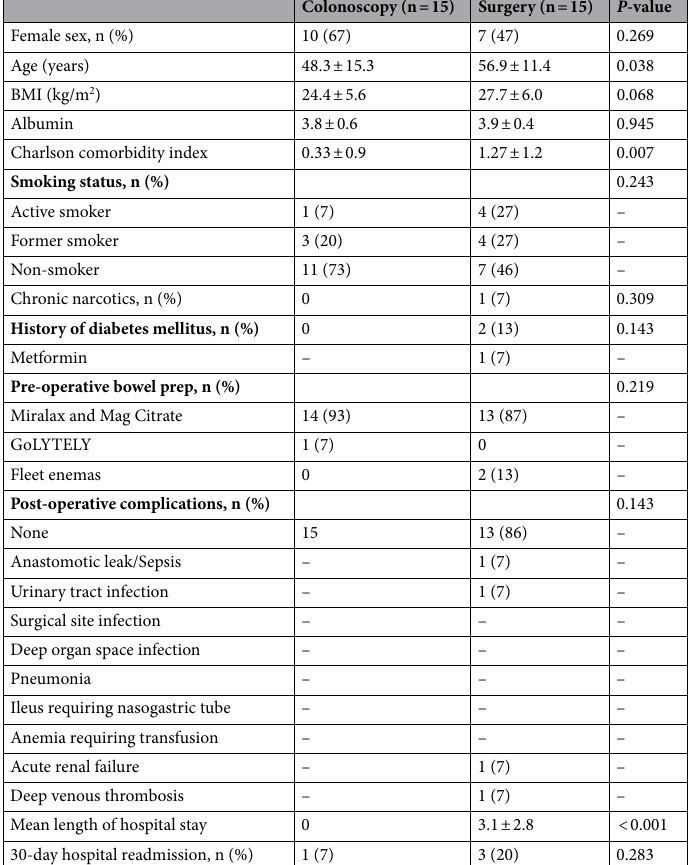
Table 1. Patient demographic and clinical data. Continuous data presented as mean ± standard deviation. BMI body mass